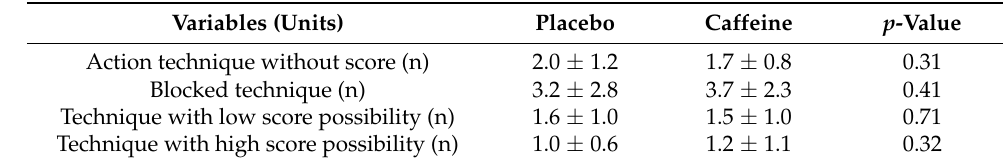
Table 2. Total offensive and defensive technical actions during traditional jiu-jitsu combat after the administration of 3 mg/kg body mass of caffeine or